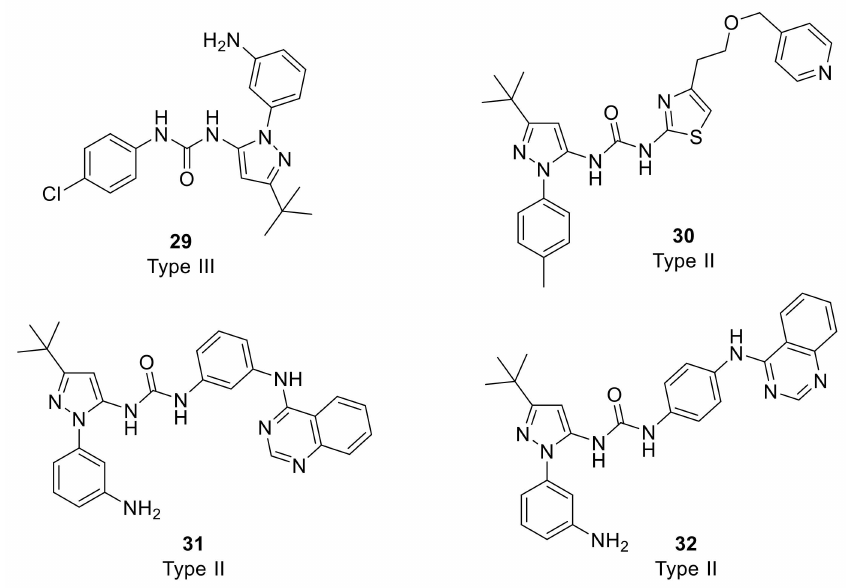
Figure 10. Chemical structures of type II and III DFG-out binders for DDR2 ( 29 – 32 ).